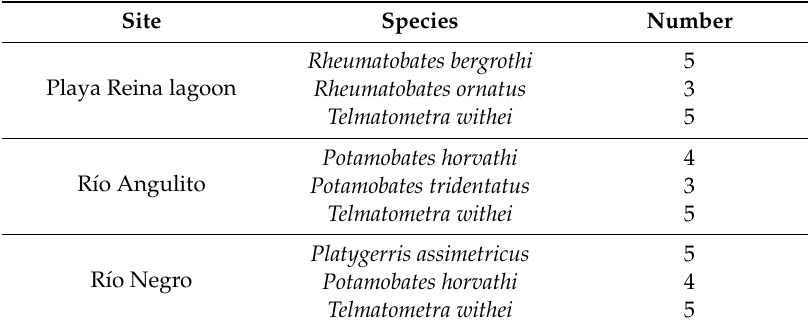
Table 1. Number of individuals of six water strider species sampled at three sites on the Western Azuero Peninsula,